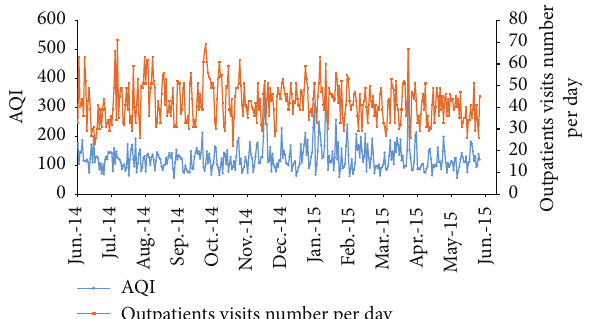
Figure 2: The patients number per day has positive relation with AQI 0 ( 𝑃 = 0.023 ), AQI 1 ( 𝑃 = 0.049 ), and AQI 2 ( 𝑃 = 0.050 ), but not AQI 3 ( 𝑃 = 0.229 ) and AQI 4 ( 𝑃 = 0.101